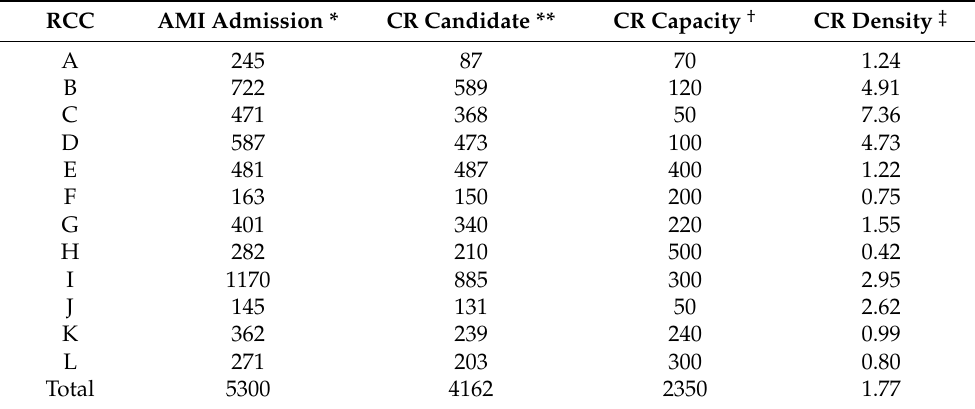
Table 3. Annual AMI Admission, CR Candidate, CR Capacity, and CR Density in 12 RCCs.